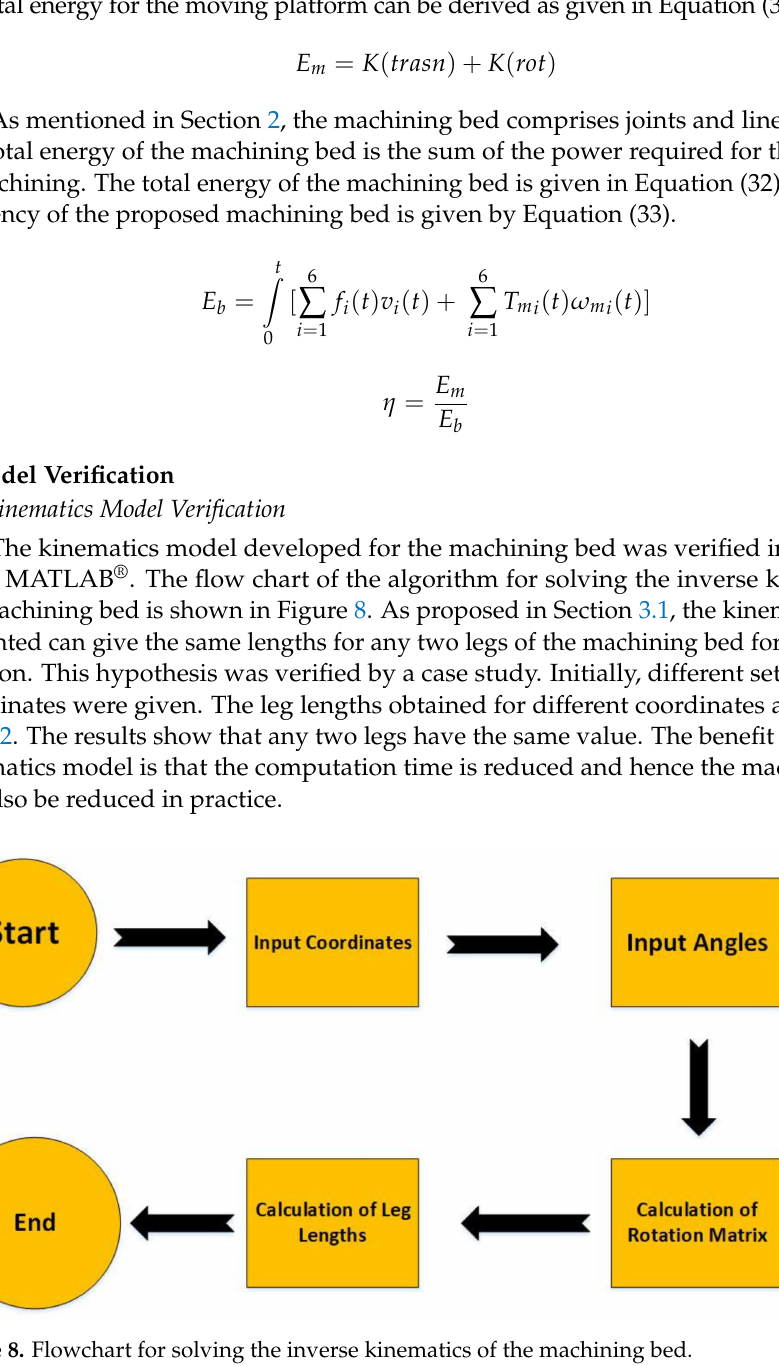
Figure 8. Flowchart for solving the inverse kinematics of the machining